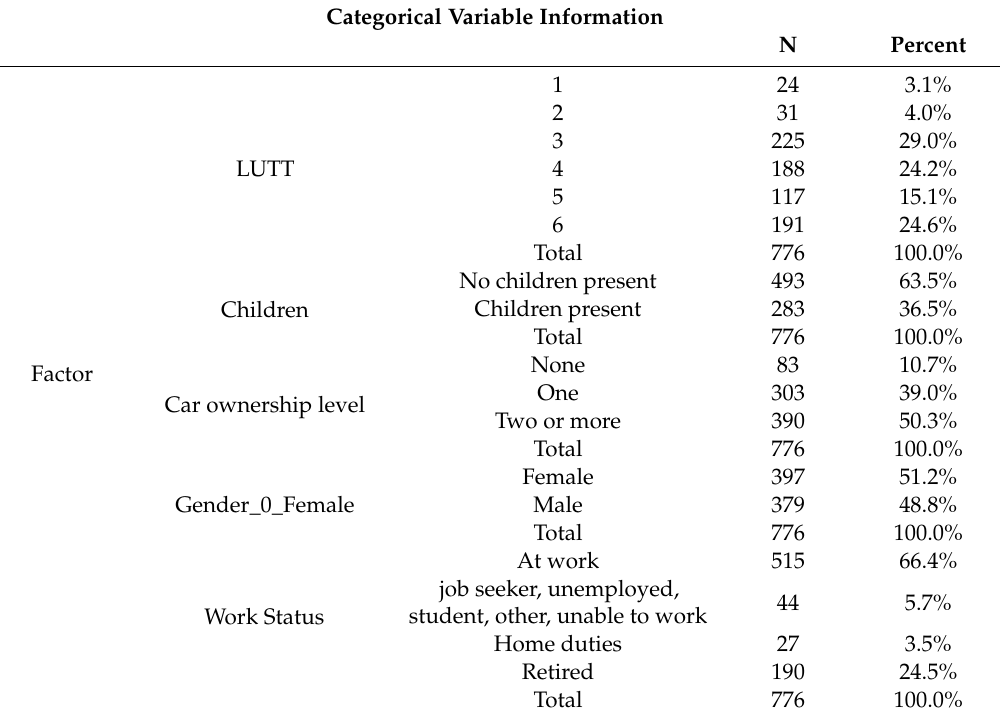
Table A3. Categorical Variable Information.